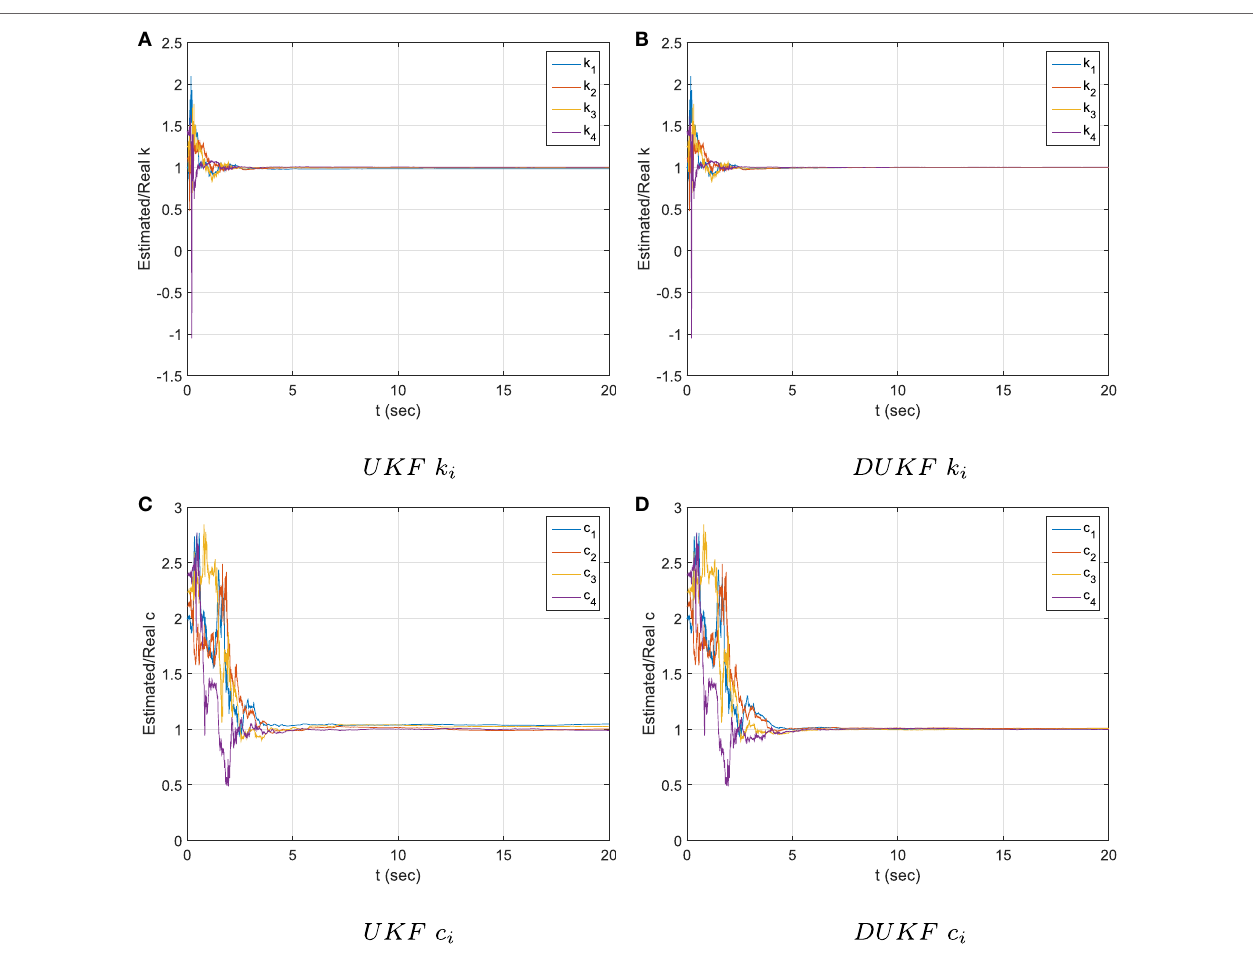
FIGURE 8 | Spring and damping parameters identified by the UKF and